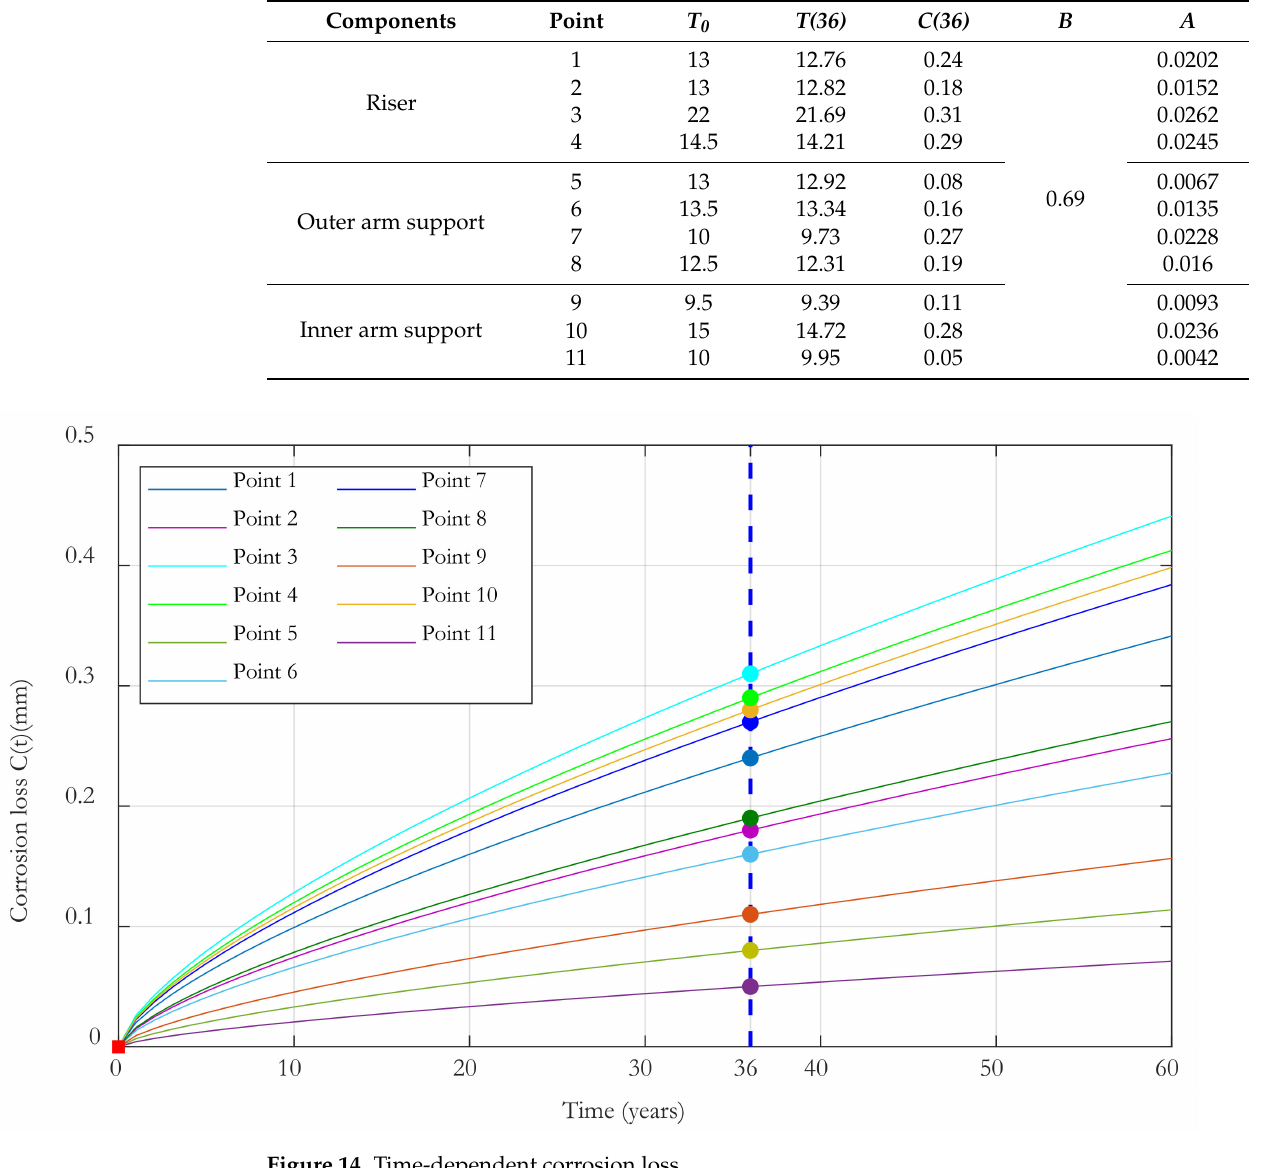
Figure 14. Time-dependent corrosion